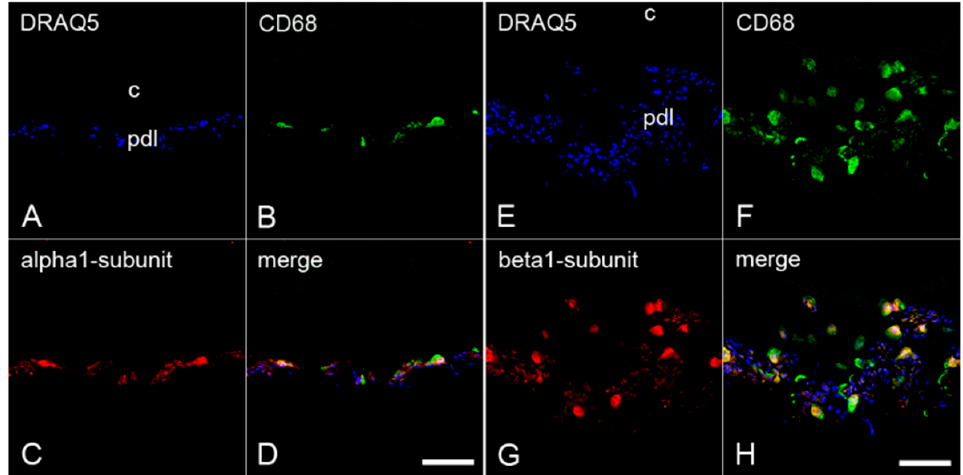
Figure 3. Colocalization of the α 1 - and β 1 -subunits of sGC with CD68 in cementoclasts of inflamed human periodontium: sections of a representative molar with adherent clinically inflamed periodontium were stained with Deep Red Anthraquinone 5 (DRAQ5) ( A , E ) and incubated with antibodies for CD68 ( B , F ), α 1 -subunit ( C ), and β 1 -subunit ( G ) of sGC. Colocalization of CD68 with the α 1 -subunit ( D ) and β 1 -subunit ( H ) in cementoclasts is depicted in the merged images. c = cementum, and pdl = periodontal ligament. Scale bar = 100 µm ( D , H ).